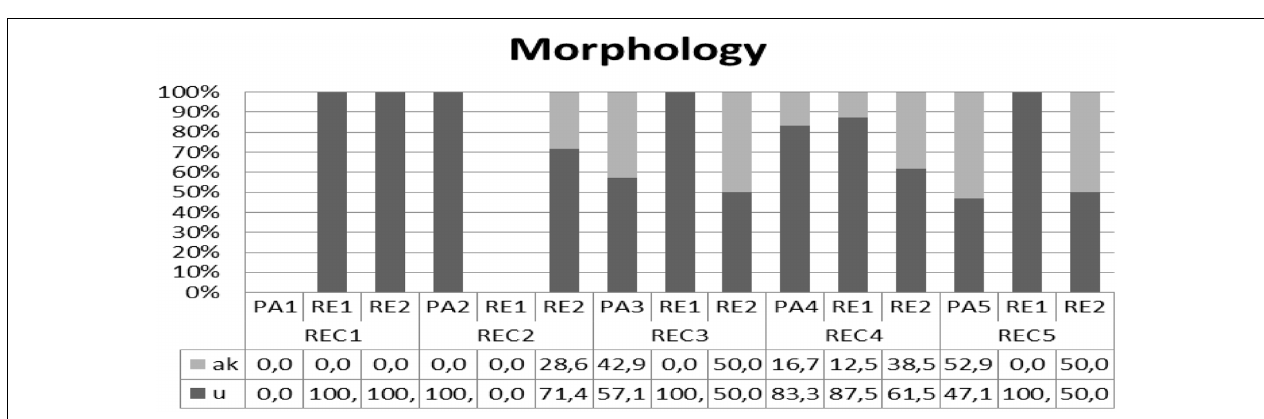
FIGURE 4 | Individual performance for each participant in